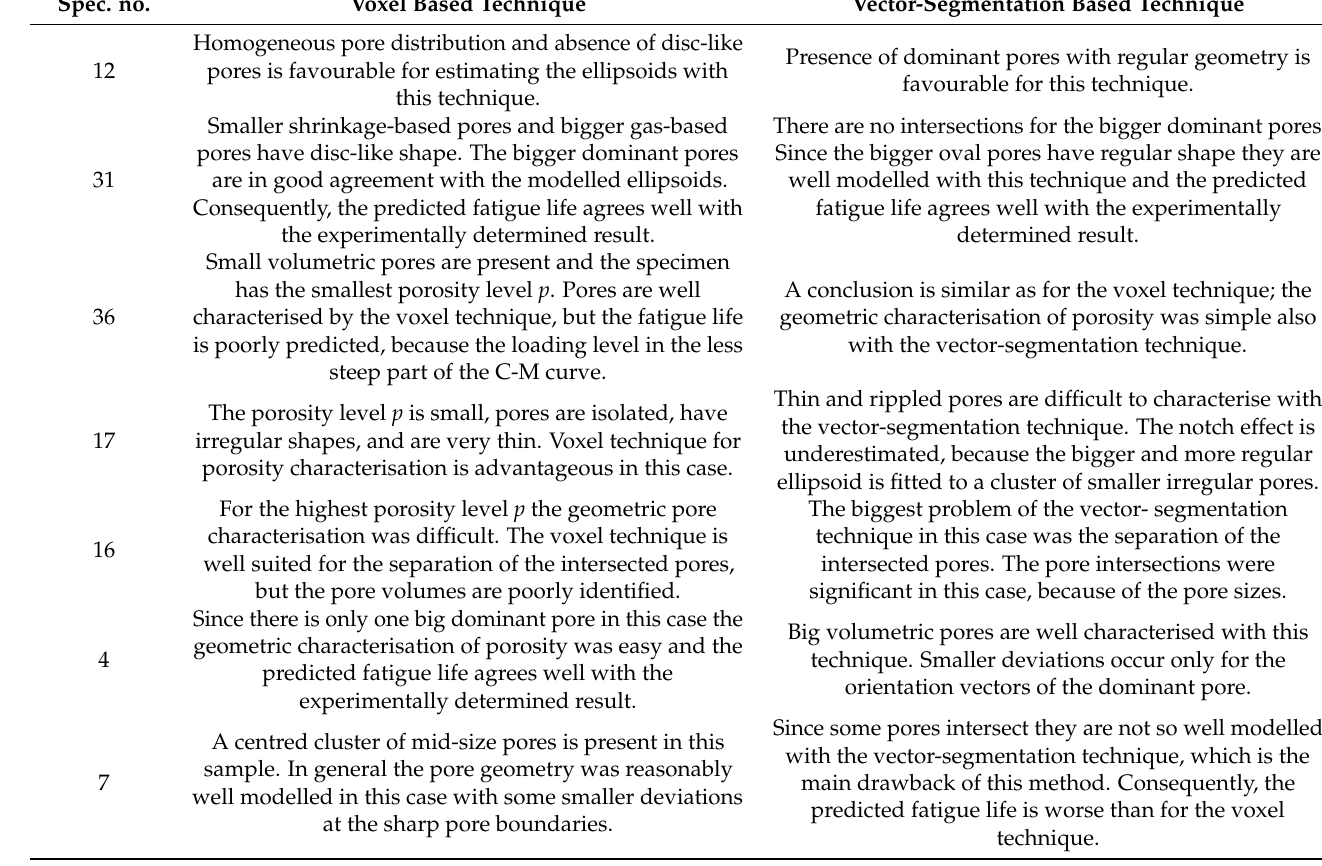
Table 6. Qualitative analysis for different techniques of pore characterisation. Spec. no. Voxel Based Technique Vector-Segmentation Based